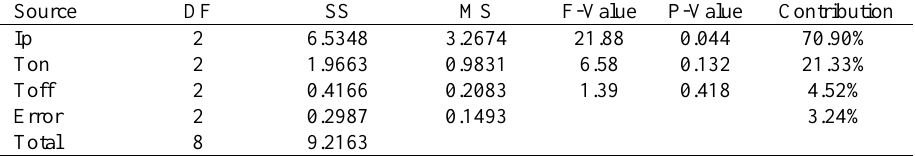
Table 9. ANOVA for S/N ratio of Cu-Gr electrode surface roughness.